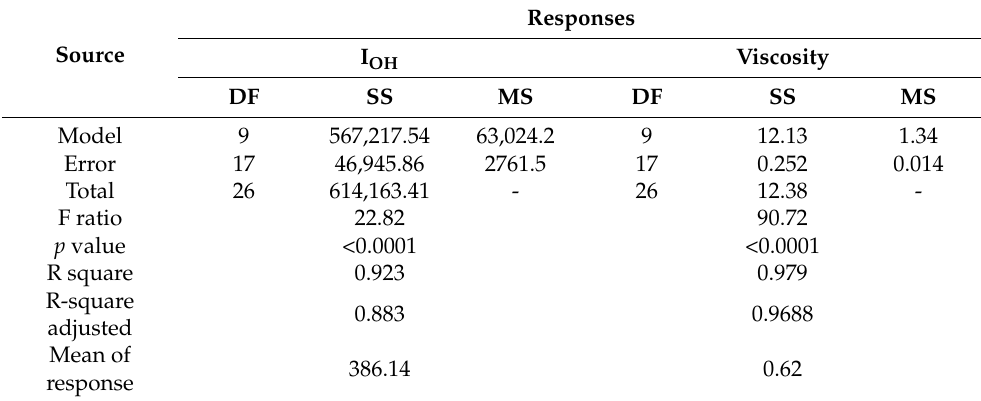
Table 3. ANOVA results for the regression models for I OH and viscosity.